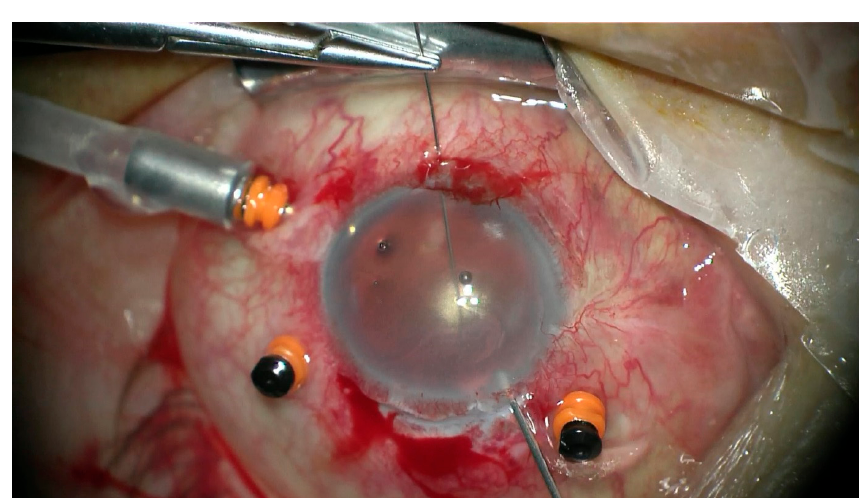
Figure 3. Performing the second scleral flap at 6 o’clock. J. Clin. Med. 2019 , 8 , x FOR PEER REVIEW